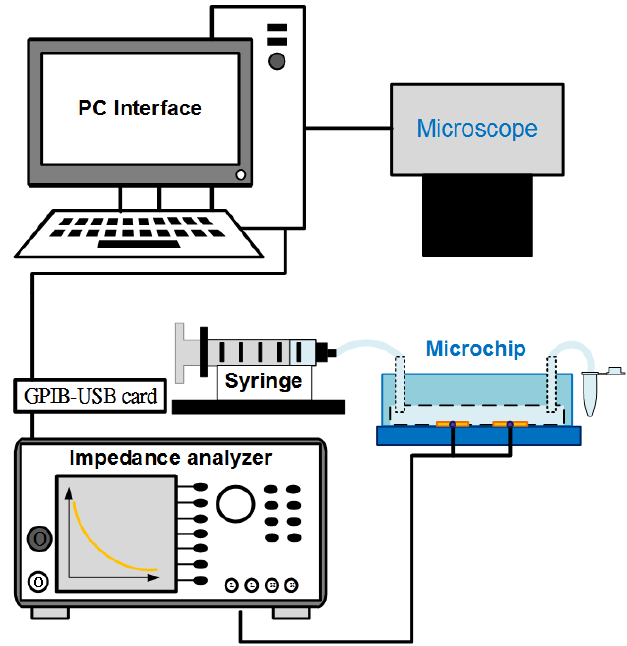
Figure 4. Diagram of experimental system using an inverted microscope and an impedance analyzer controlled with LabVIEW software interface.